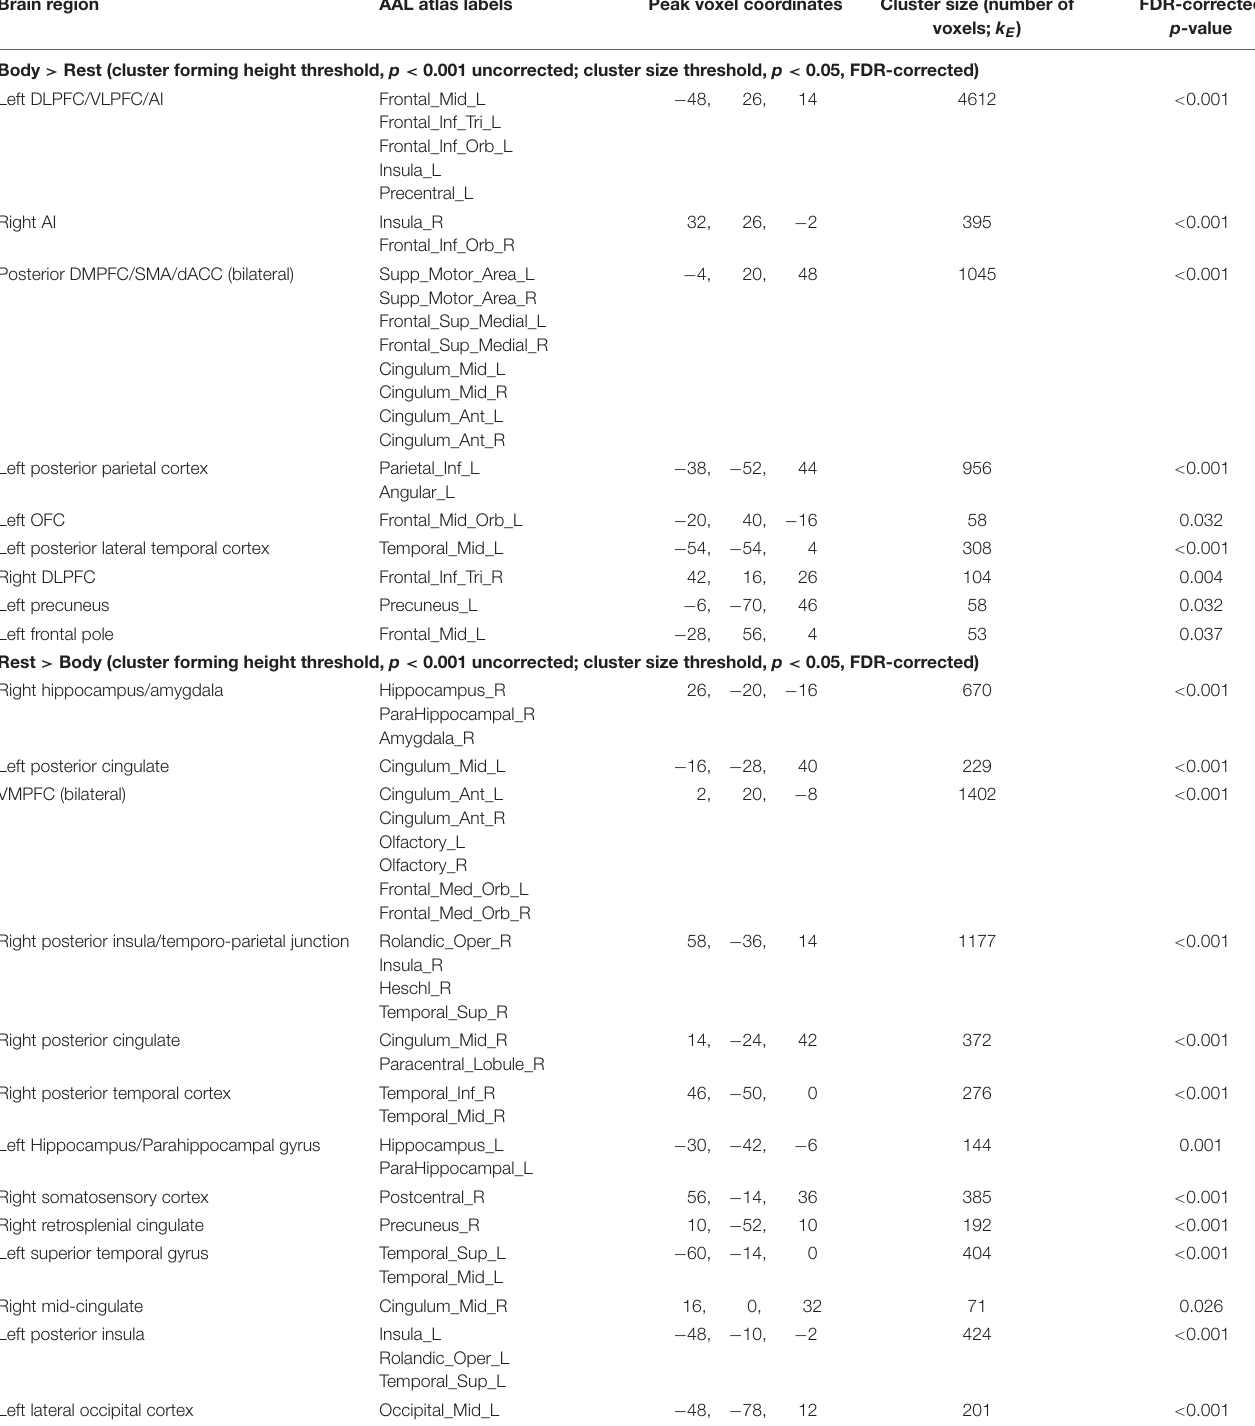
TABLE 2 | fMRI results: body vs. rest. Brain region AAL atlas labels Peak voxel coordinates Cluster size (number of